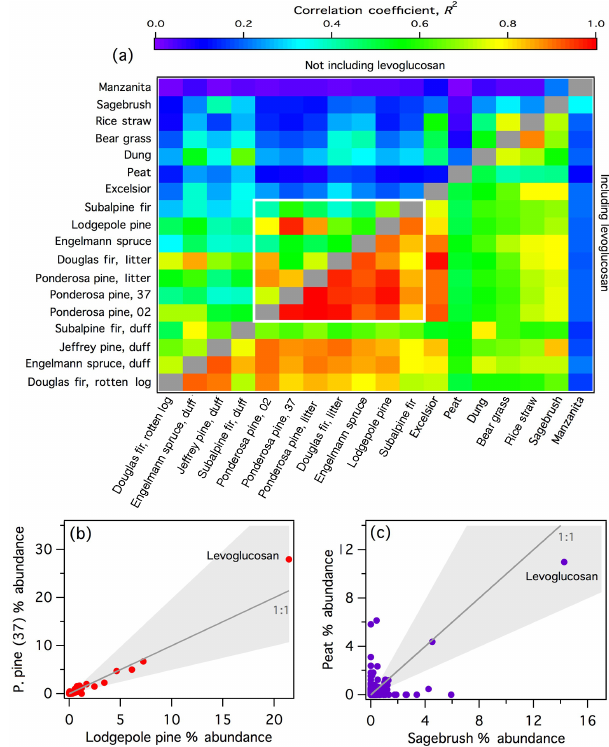
Figure 4. (a) Correlation coefficients ( R 2 ) for each fire pair based on the total (SPE + PTFE)% abundance for each observed com- pound. For the ponderosa pine replicates, the fire number is indi- cated. Regression values below the diagonal were calculated includ- ing all observed compounds; above the diagonal, levoglucosan was omitted. The white box bounds the conifer fires. (b) Example scat- ter plot of a highly correlated fire pair. (c) Example scatter plot of a poorly correlated fire pair. In (b) and (c) , each point represents a single compound and the shaded areas denote a factor of 2 from the 1 : 1